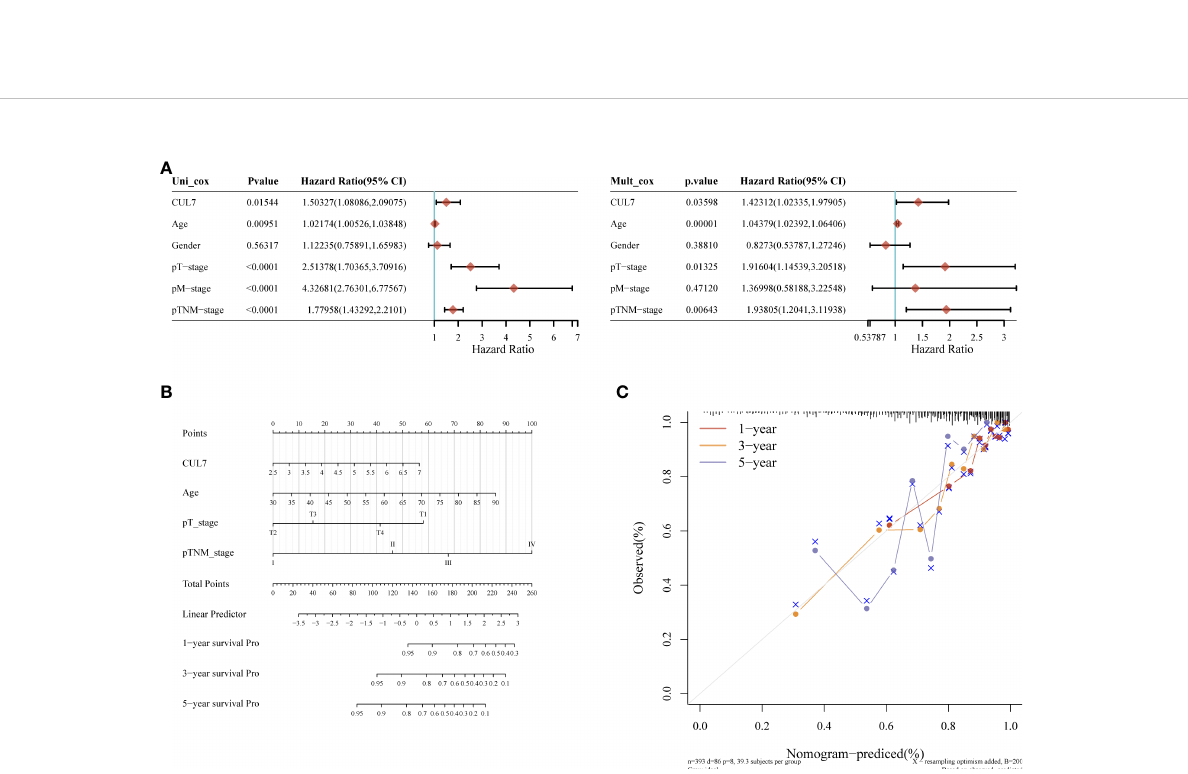
FIGURE 8 Kaplan-Meier overall survival (OS) analysis of COAD patients with high and low expression levels of CUL7. (A) mono-factor and multi-factor analysis. (B) Nomogram of multi-factor analysis results. (C) Calibration diagram.